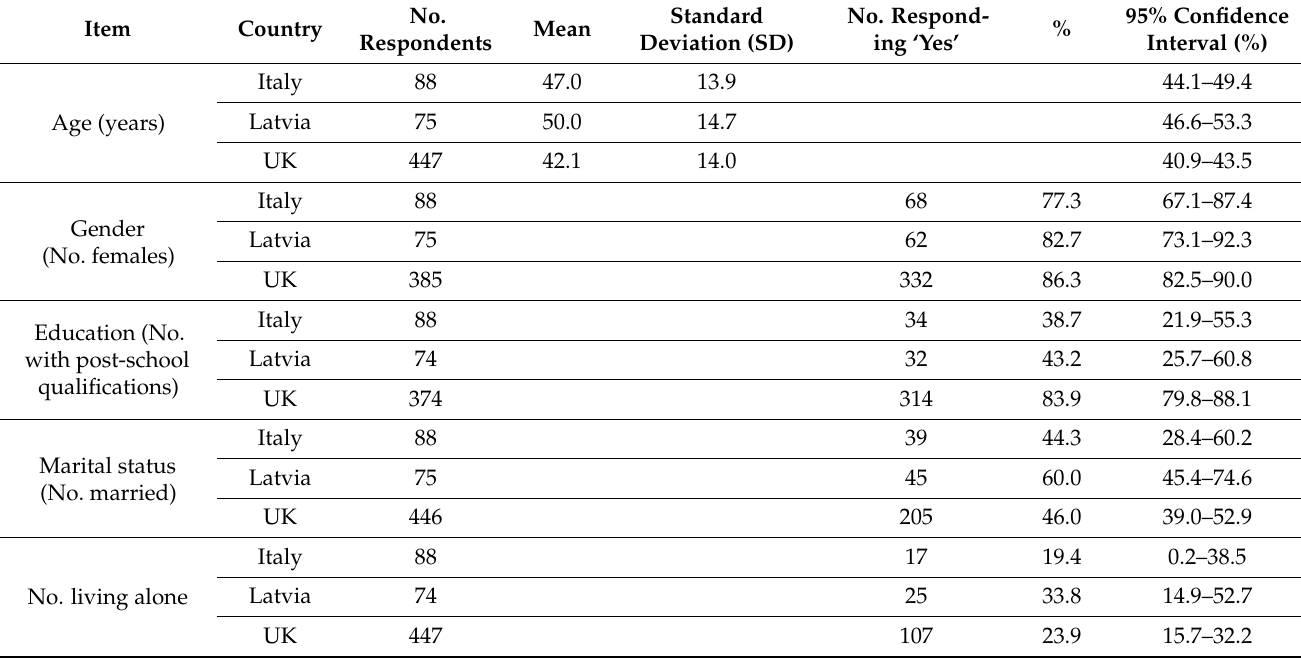
Table 1. Sociodemographic